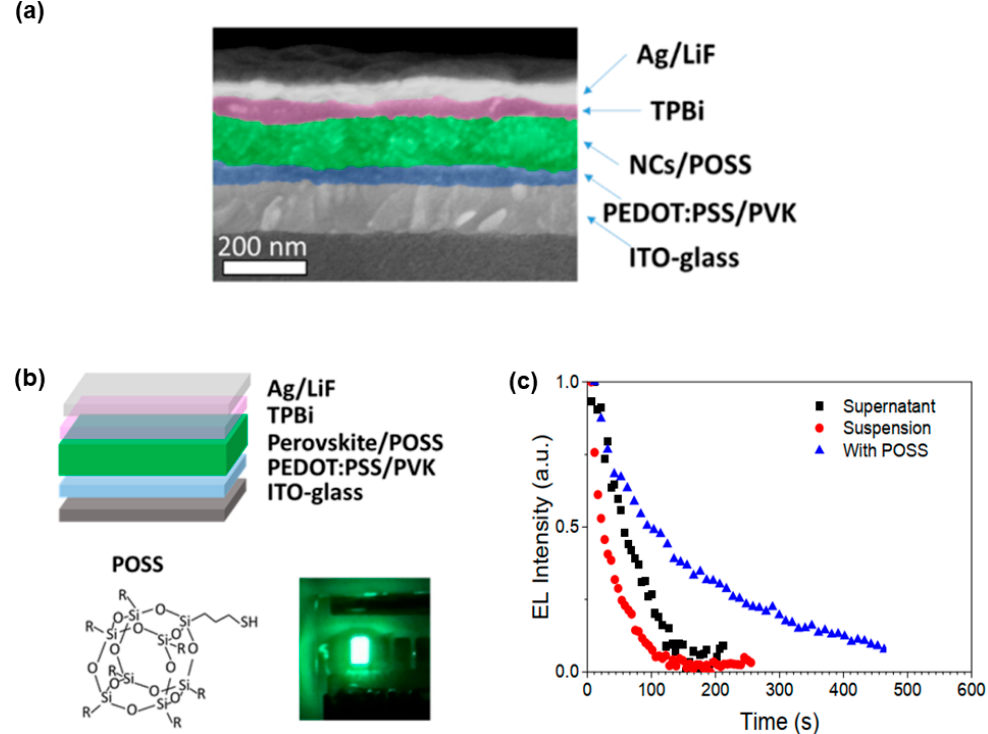
Figure 6. ( a ) Cross-sectional scanning electron microscope (SEM) image of PeLEDs. ( b ) Schematic illustration of the use of polyhedral oligomeric silsesquioxane (POSS) for high-performance PeLEDs. ( c ) EL stability measurements for different PeLEDs. Reproduced from reference [193], American Chemical Society, 2016.